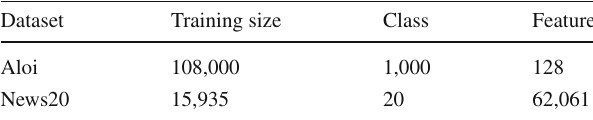
Table 3 Summary of